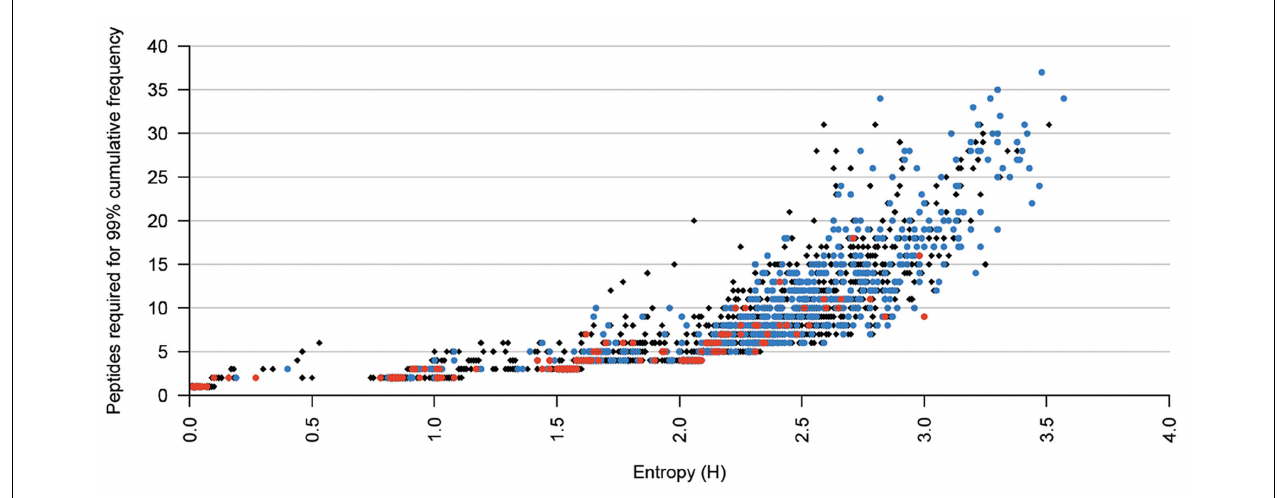
bind to the HLA.The blue circles indicate that some, but not all, peptides within that block are predicted to be epitopes.The red squares indicate that all peptides within the block are predicted to bind the same HLA type.